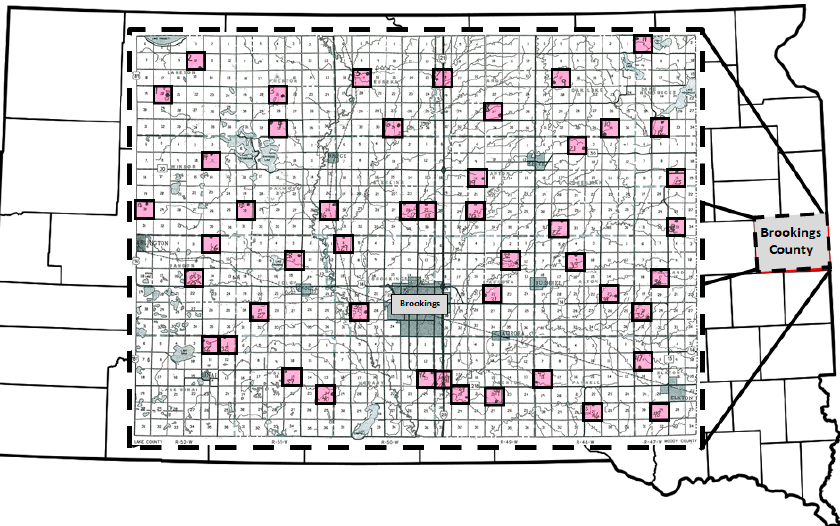
Figure 1. Location of sample sites in the geographic survey of Brookings County, SD. Shaded squares with bold outlines indicate the townships in which wild sunflowers were sampled.